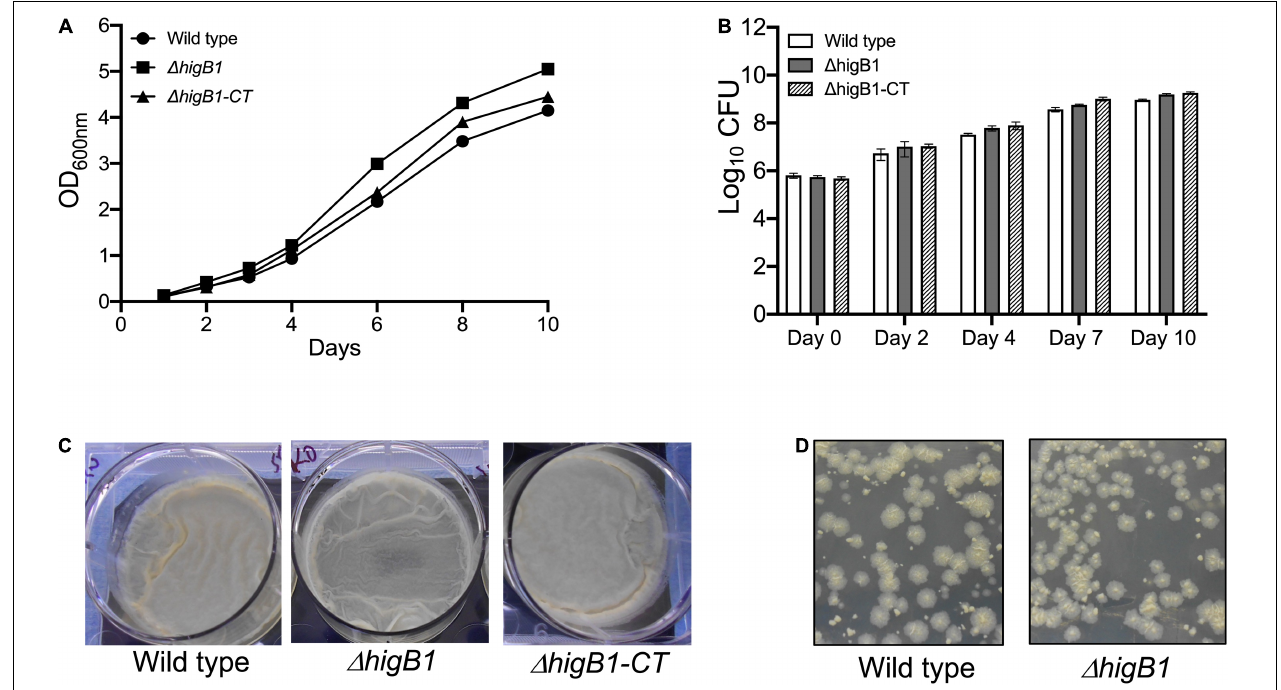
FIGURE 2 | Deletion of HigB1 does not affect in vitro growth of M. tuberculosis . (A,B) The growth patterns of various strains were compared by measuring absorbance at 600 nm (A) and CFU enumeration (B) . The biofilm formation (C) and colony morphology (D) was performed as described in section “Materials and Methods.” The data presented shown in (A,C,D) panels is representative of two independent experiments. The data shown in panel (B) is mean ± SE of Log 10 CFU obtained from two independent experiments performed in duplicates.